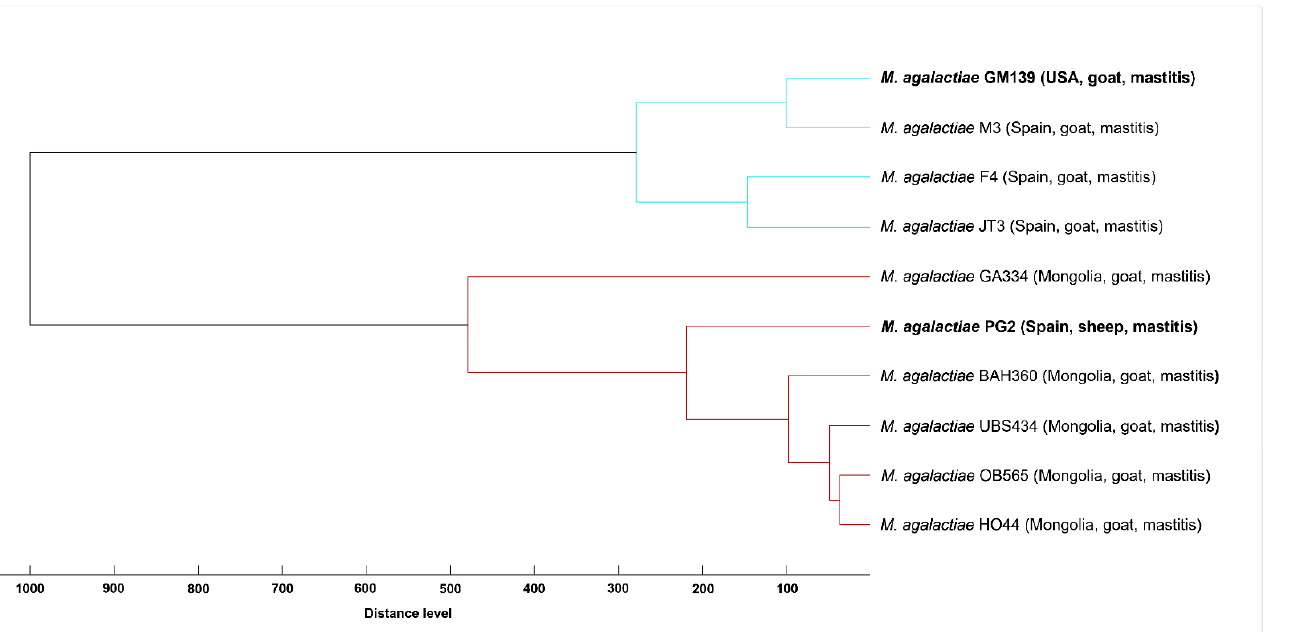
Figure 2. Score-oriented dendrogram based on distances between MSPs created from M. agalactiae GM139 and PG2 compared to MSPs of M. agalactiae strains from Spain and Mongolia integrated in the in-house mycoplasma library.